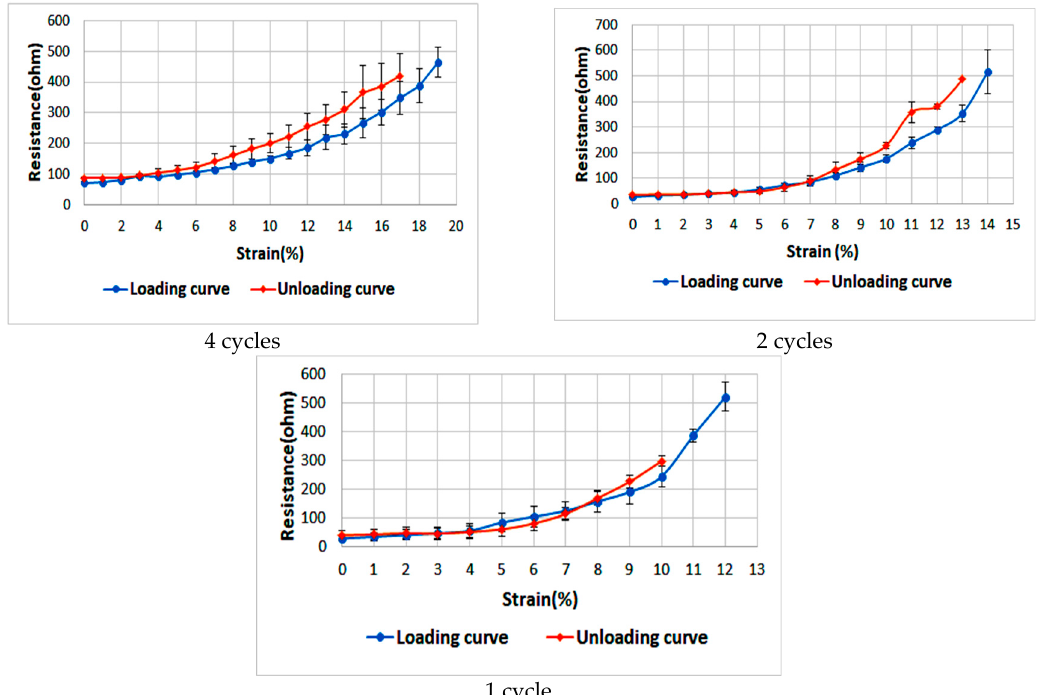
Figure A4. Average resistances of two sinusoidal samples at various cycles as the applied strain increases (loading) and decreases (unloading). Error bars indicate the standard deviation in the values of the resistances.